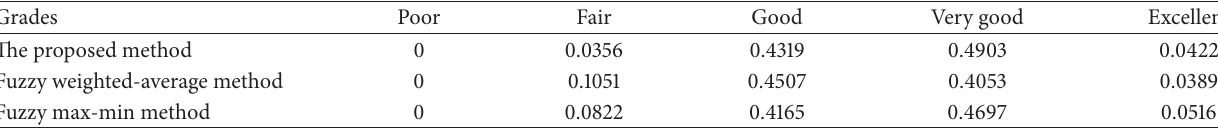
Table 5: Comparison of the results with the other two methods.